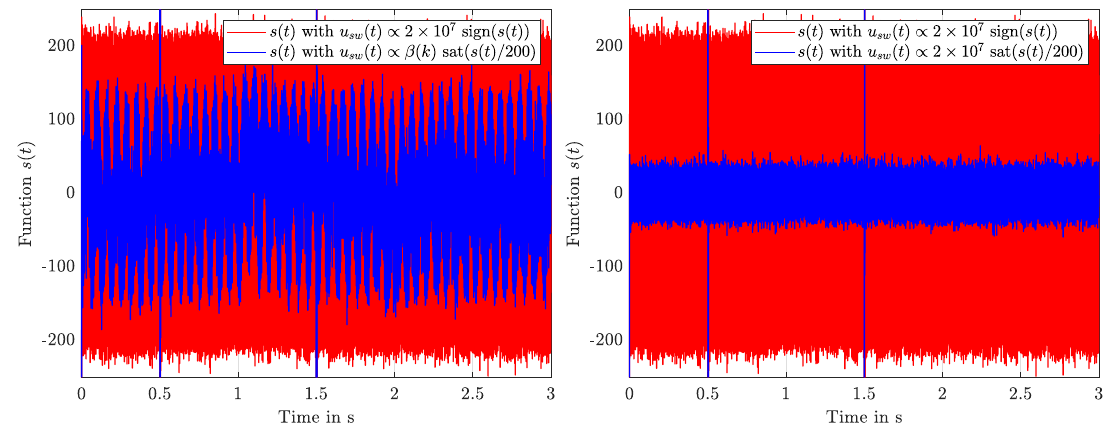
Figure 11. Simulated values for the sliding surface s ( t ) for all the